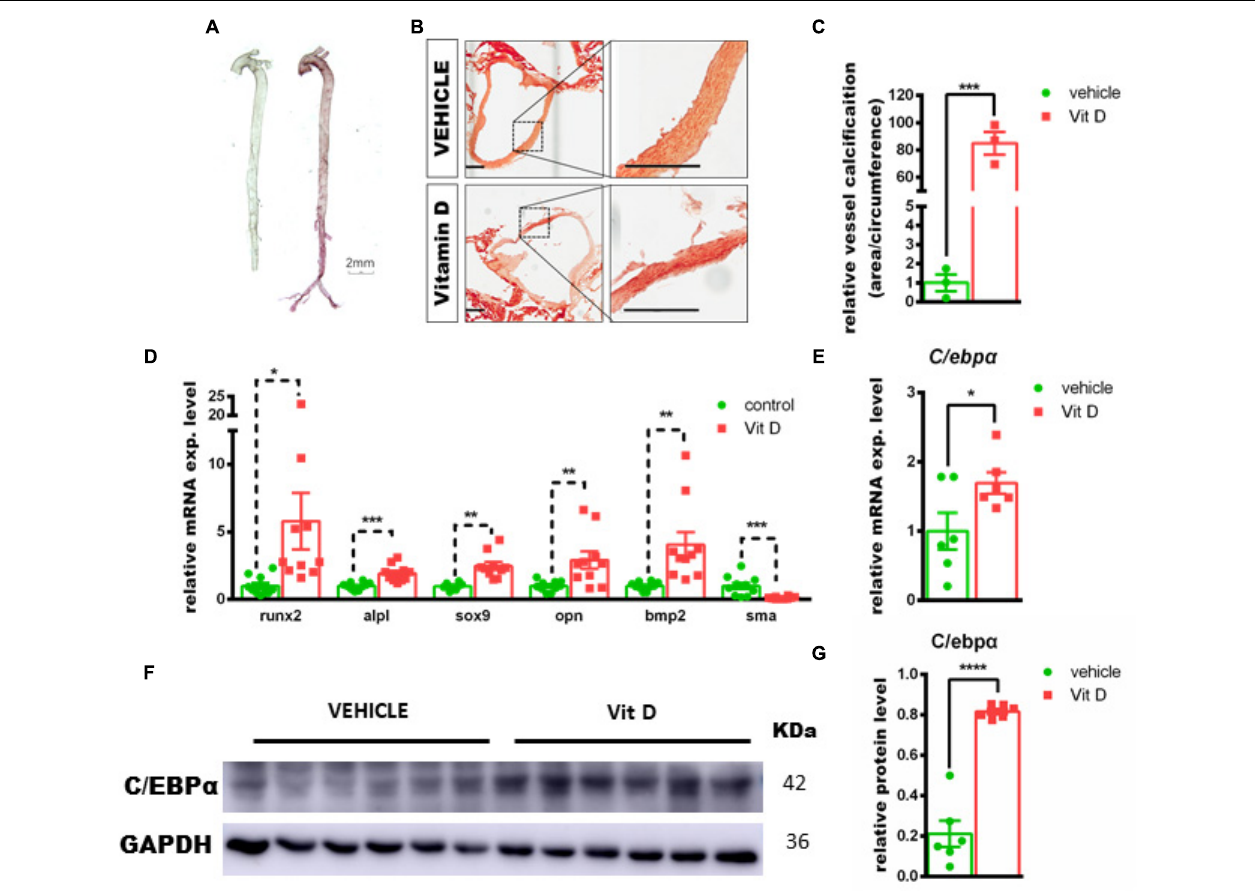
FIGURE 1 | Association of CCAAT/enhancer-binding protein alpha (c/ebp α ) with vascular calcification in the murine vascular calcification model. (A) Alizarin red staining for calcium deposition in aorta from vitamin D (vD)-treated mice. Scale bar, 2 mm. (B) Typical images at 100 × magnification of aorta paraffin section from vD-treated mice or vehicle-treated mice stained by alizarin red; the indicated areas are enlarged by 4-fold and placed beside the respective panels. Scale bar, 200 µ m. (C) Semiquantitative analysis of vascular wall calcification presented at area to circumference ratio ( n = 3). (D–E) Real-time PCR for mRNA expression of Runt-related transcription factor 2 (Runx2), Alpl, sex-determining region Y-box 9 (Sox9), bone morphogenetic protein-2 (Bmp2), osteopontin (Opn), Sma, and c/ebp α in vascular calcified aortas for indicated experimental groups. The target mRNAs were normalized to β -actin mRNA and are graphed ( n = 8). (F) Representative images of Western blotting for C/EBP α in vascular calcification aortas from vD-treated mice and vehicle controls. (G) Semiquantitative analysis of Western blotting for C/EBP α protein expression using ImageJ software ( n = 6). * p < 0.05, ** p < 0.01, *** p < 0.001, **** p <